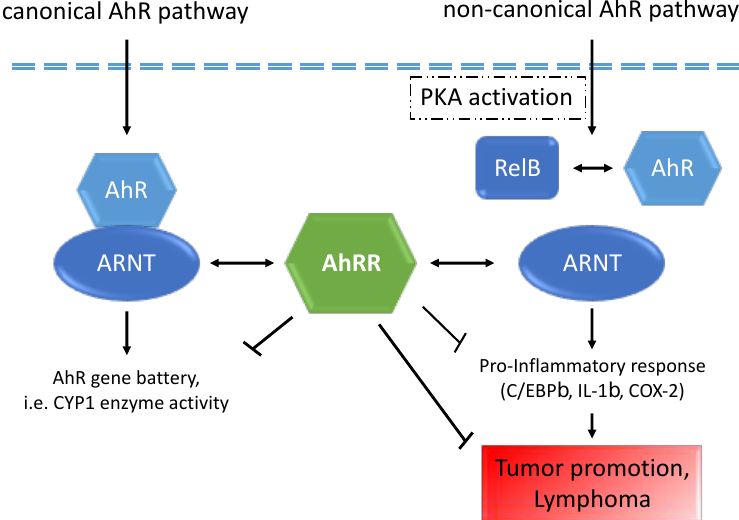
Figure 8. A schematic diagram illustrates our hypothesis how AhRR may interact with the canonical and non-canonical AhR signaling pathways as described recently [11]. AhRR may suppress inflammatory responses and tumor promotion via interaction with RelB in complex with AhR and ARNT. Double arrows depict the interaction of AhRR with ARNT and RelB with